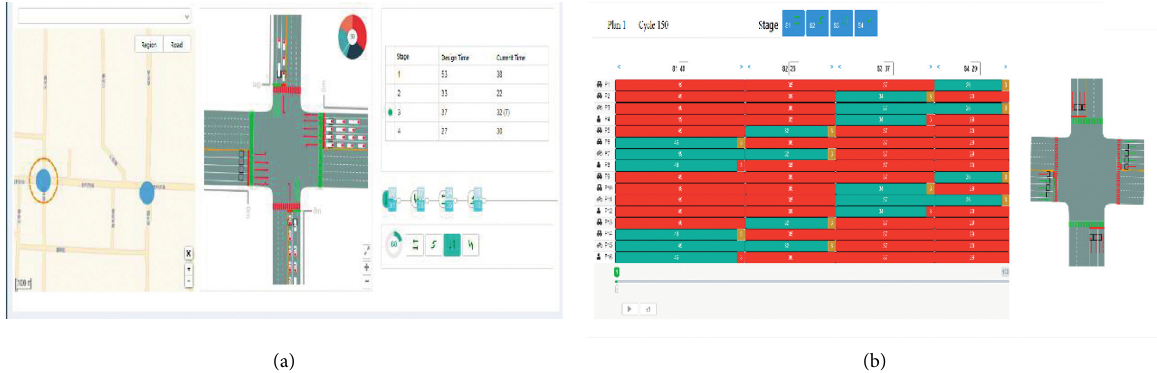
Figure 3: System architecture of the “UTSC-CPS” urban road traffic signal control platform. (a) Traffic signal control. (b) Traffic signal control